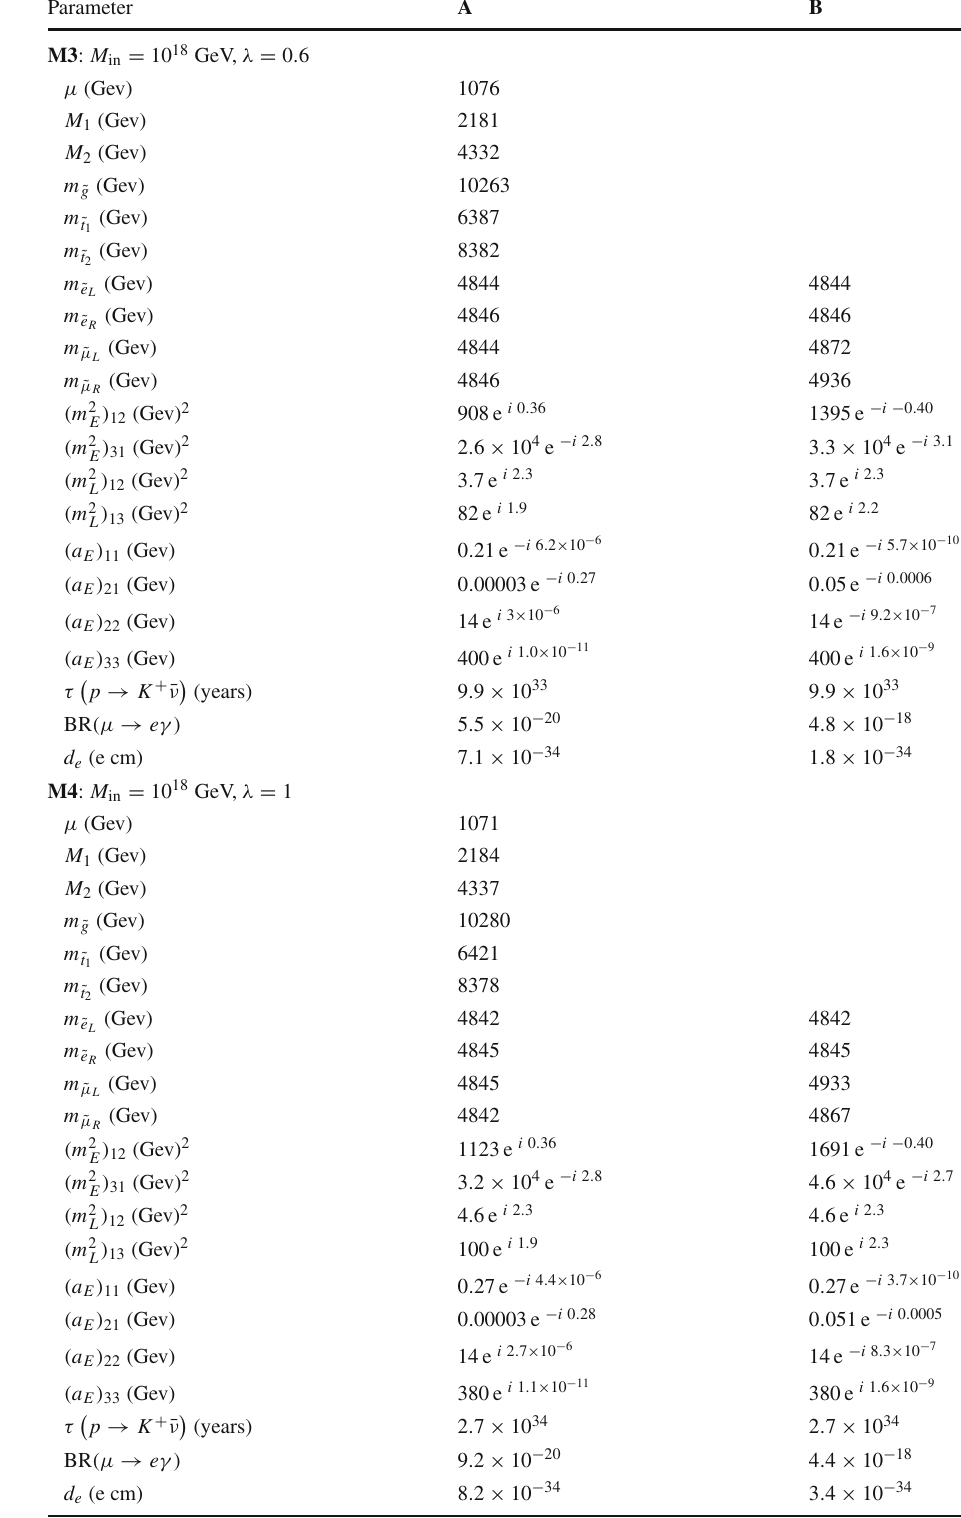
Table 2 Benchmark points in Parameter A B models M3 and M4 with m 1 / 2 = 6000 GeV. For M3, M3 : M in = 10 18 GeV, λ = 0 . m 1 = 7850 GeV, and for M4, m 1 = 9780 GeV. We list values of the parameters relevant for BR (μ → e γ) and the electron EDM obtained with flavor choices A and B , as well as the corresponding predictions for (cid:2) (cid:3) τ , BR (μ → e γ) p → K + ¯ ν and the electron EDM